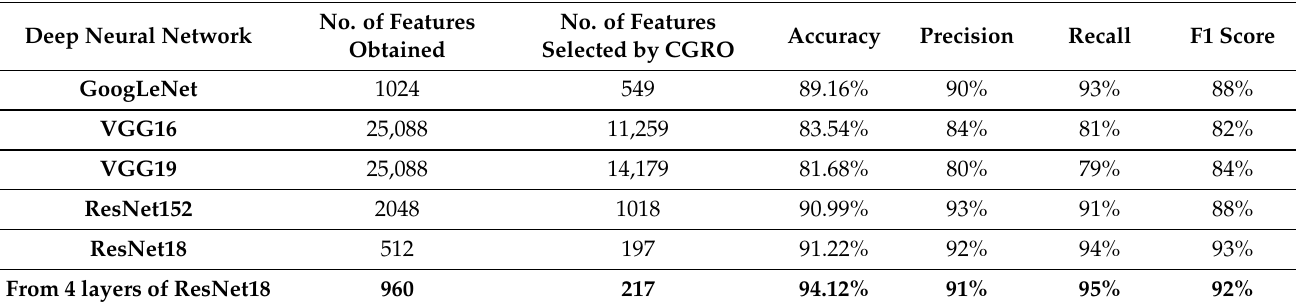
From 4 layers of ResNet18 Table 5. The results obtained on X-ray 3-class dataset using different models. Different parameters and obtained results with 4 layers features of ResNet18 are highlighted boldly in the